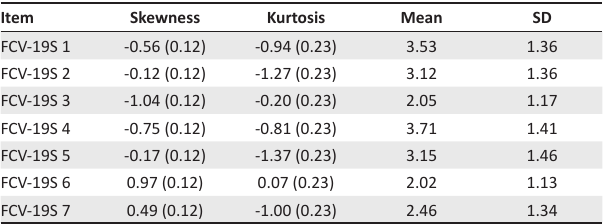
TABLE 2: Normality, mean and standard deviation of the FCV-19S items.